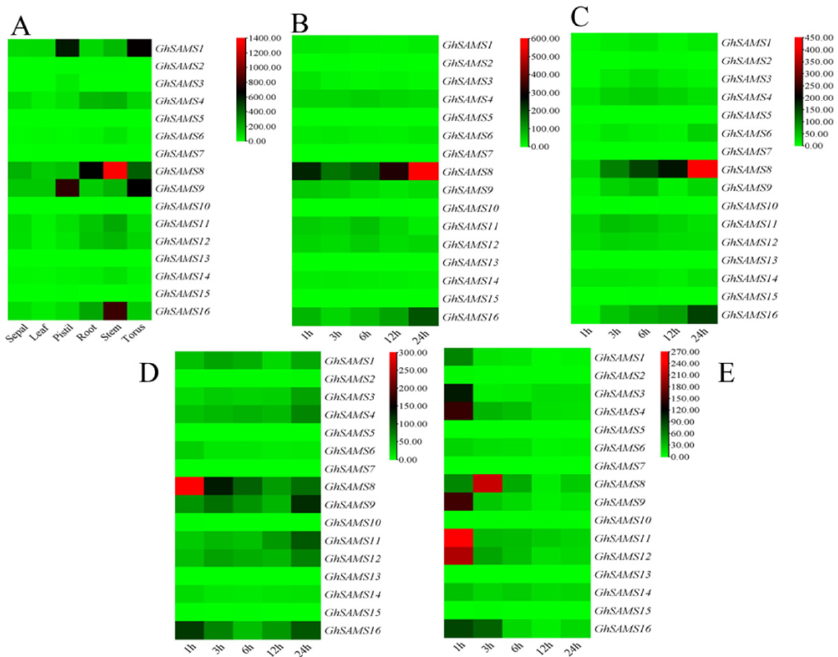
Figure 6. ( A ) Expression analysis of GhSAMS gene (log 2 (FPKM)). ( B ) Expression analysis of GhSAMS gene after drought stress. ( C ) Expression analysis of GhSAMS gene after salt stress. ( D ) Changes in GhSAMS gene expression in different periods after cold stress. ( E ) Changes in GhSAMS gene expression in different time periods after heat stress.